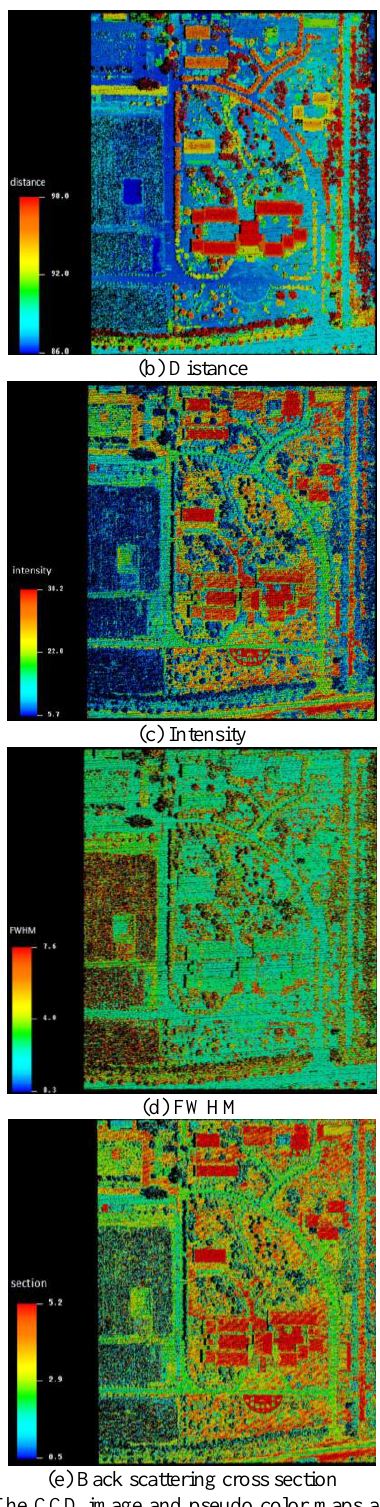
Figure 3. The CCD image and pseudo color maps according to the values of waveform